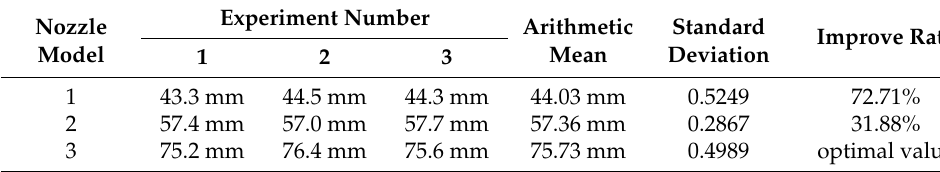
Table 12. Depth of punching.